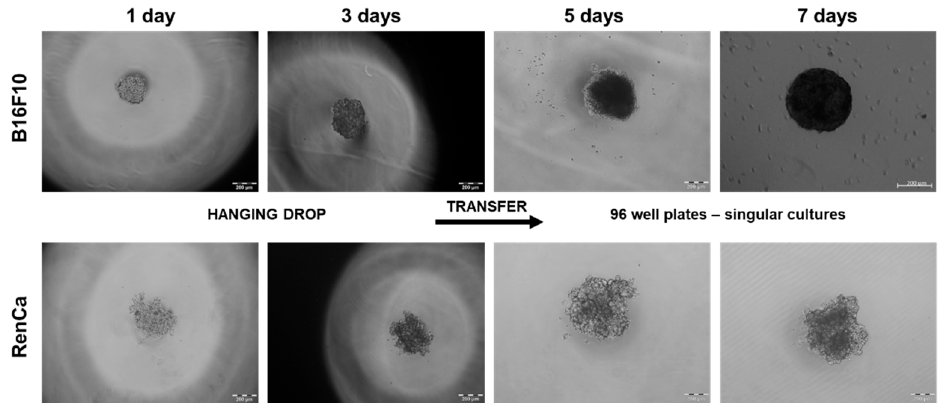
Figure 1. Spheroid formation for 7 days . B16F10 and RenCa cell lines were seeded 500 of cells per drop in RPMI medium supplemented with methylcellulose; 3 days after cultivation in hanging drops, cell aggregates were transferred in agarose coated 96-well plates, and cultivated for another 4